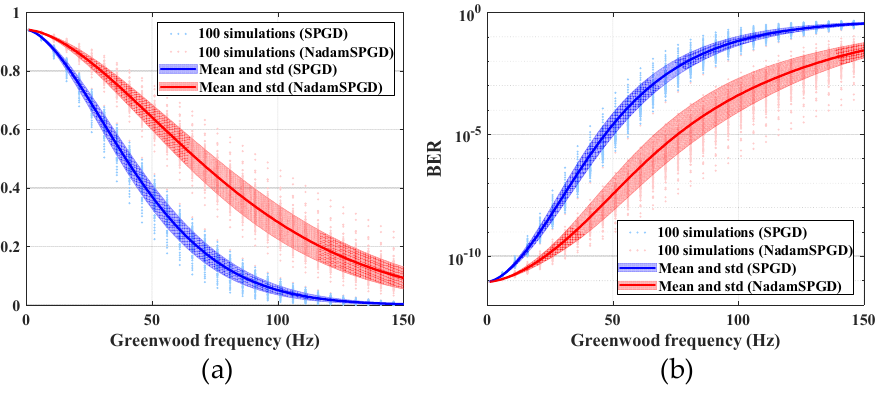
Figure 9. Comparison of ME and BER between SPGD and NadamSPGD under different GFs. ( a ) ME of the two algorithms under different GFs. ( b ) BER of the two algorithms under different GFs.